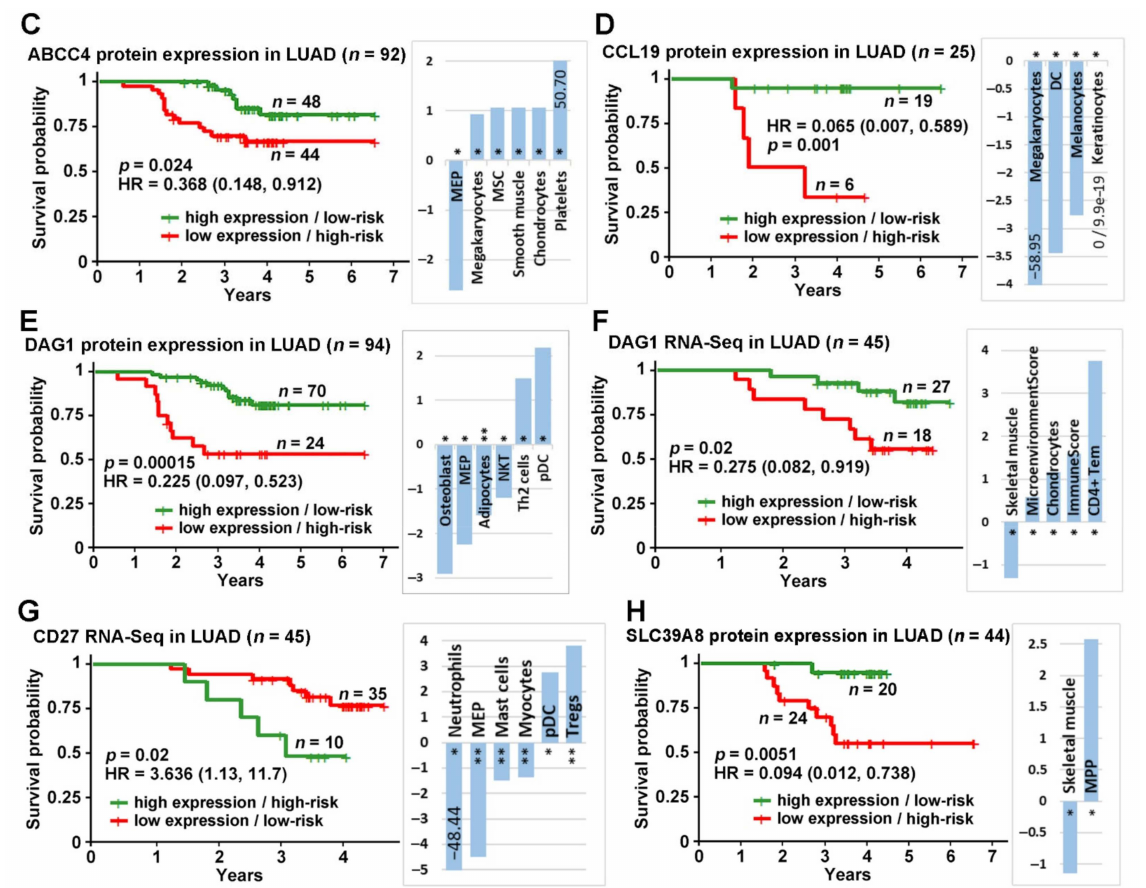
Figure 1. The prognosis of the seven-gene panel using RNA sequencing and proteomic profiles in NSCLC tumors. Kaplan–Meier analysis and log 2 ratio of xCell scores of the high-risk group vs. the low-risk group using: ( A ) three-gene (ABCC4, SLC39A8, and DAG1) Cox model in LUAD proteomics data; ( B ) RNA sequencing data of ABCC4 in TCGA-NSCLC; ( C ) proteomics data of ABCC4 in LUAD [33]; ( D ) proteomics data of CCL19 in LUAD [33]; ( E ) proteomics data of DAG1 in LUAD [33]; ( F ) RNA sequencing data of DAG1 in LUAD [33]; ( G ) RNA sequencing data of CD27 in LUAD [33]; ( H ) proteomics data of SLC39A8 in LUAD [33]. Two sample t -tests were performed to test the difference between the two groups (*: p < 0.05; **: p < 0.01; ***: p <